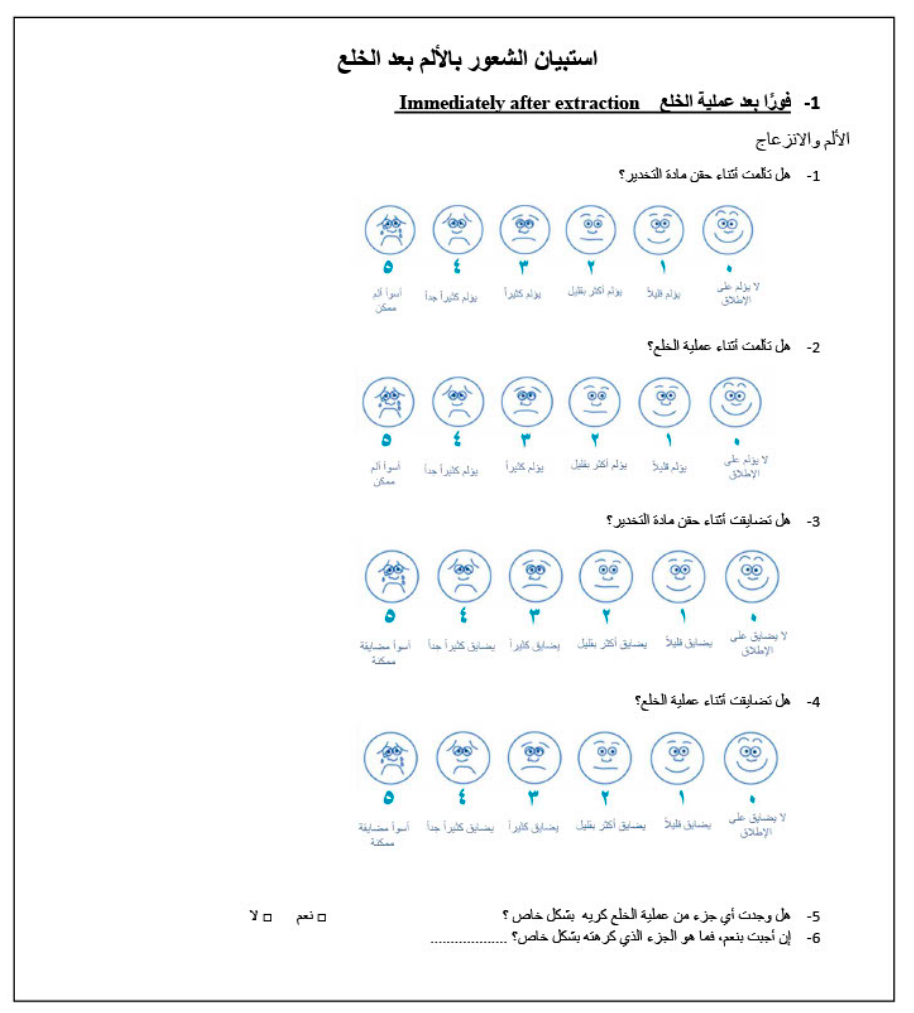
Figure 1. A sample of the first part of the Arabic post-extraction pain experience questionnaire. The